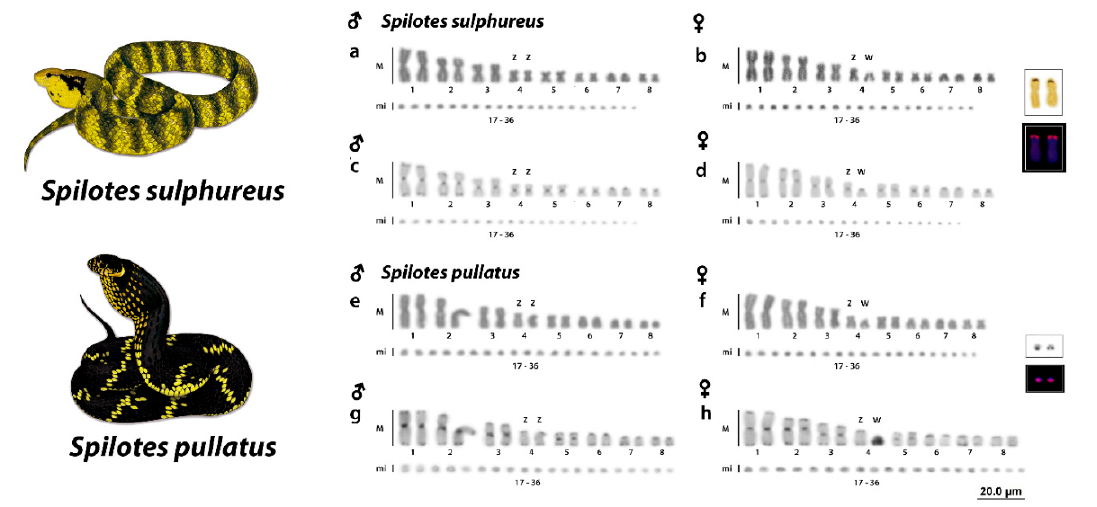
Figure 1. Karyotypes of Spilotes sulphureus ( A , B ) and Spilotes pullatus ( E , F ) in Giemsa-staining and C-banding ( C , D , G , H ), respectively, chromosomes showing the heteromorphism of the fourth pair in both females. Note the euchromatic and heterochromatic W chromosomes in S. sulphureus and S. pullatus , respectively ( D , H ). Highlighted in the boxes the mapping of nucleolar organizer regions (NORs) and rDNA 18S. Illustrations by Bruna Borges.